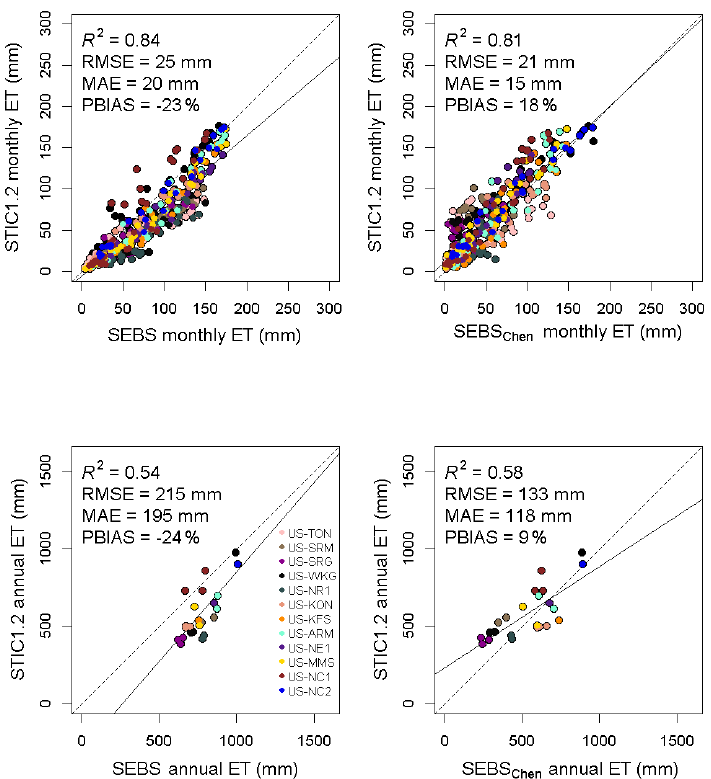
Figure 14. Scatter plots of monthly and annual ET estimates from STIC1.2 against those from SEBS and a recently developed global SEBS products (Chen et al., 2013) with improved kB − 1 characterization. Monthly SEBS and STIC1.2 ET estimates were produced using an aggregation of 8-day average EF multiplied by monthly total net radiation (similar to Eq.